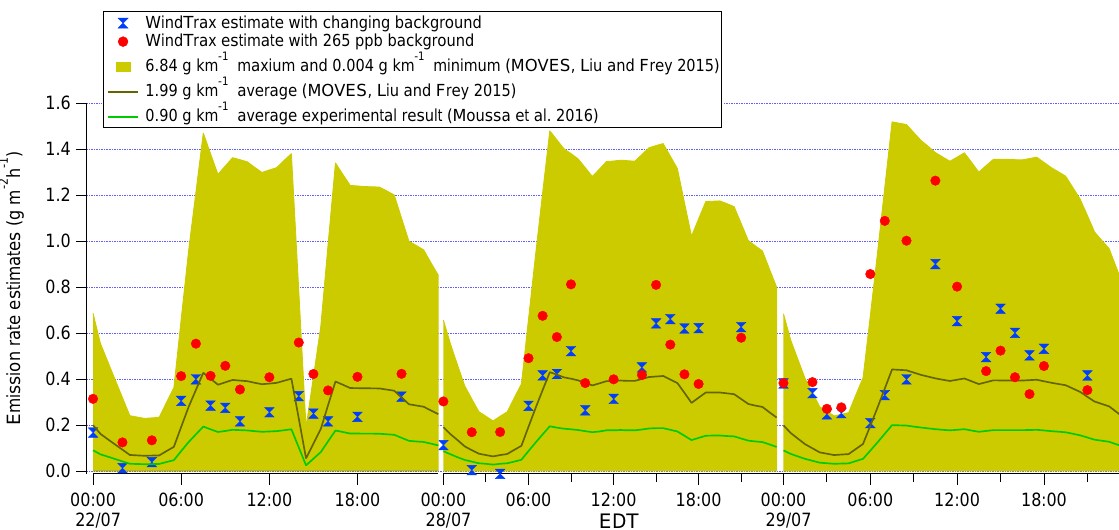
Figure 13. CO emission rate estimates over 3 days. Red dots are CO emission rates simulated by WindTrax using CO mixing ratios from the FTIR spectrometer and a constant CO background of 265ppb (see the text). Blue markers are CO emission rates simulated by the WindTrax using changing CO background values. The brown line is the CO emission rate estimated by using traffic volume estimates and emission factors from the average MOVES results in Liu and Frey (2015); the brown shade is the range of CO emission rates estimates obtained by using the maximum and minimum CO emission factor results from MOVES in Liu and Frey (2015). The green line is the CO emission rate simulated by using traffic volume estimates and the average CO emission factor from Moussa et al.